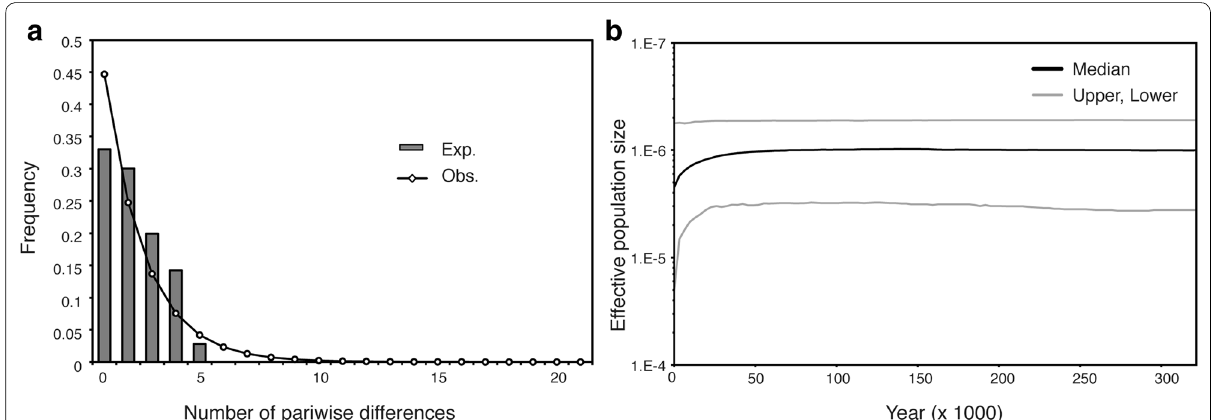
These parameters were obtained from the mismatch distribution under the spatial expansion model. Value in parentheses indicate 95% confidence intervals SSD: Sum of squared deviation